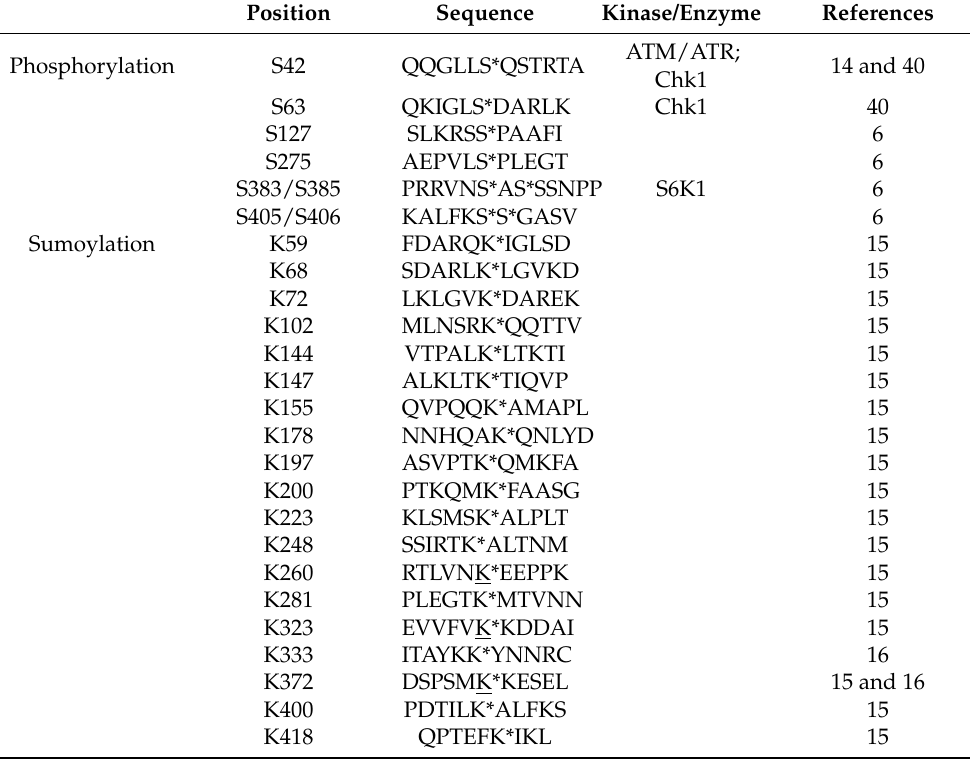
Table 1. Modifications of POLDIP3.